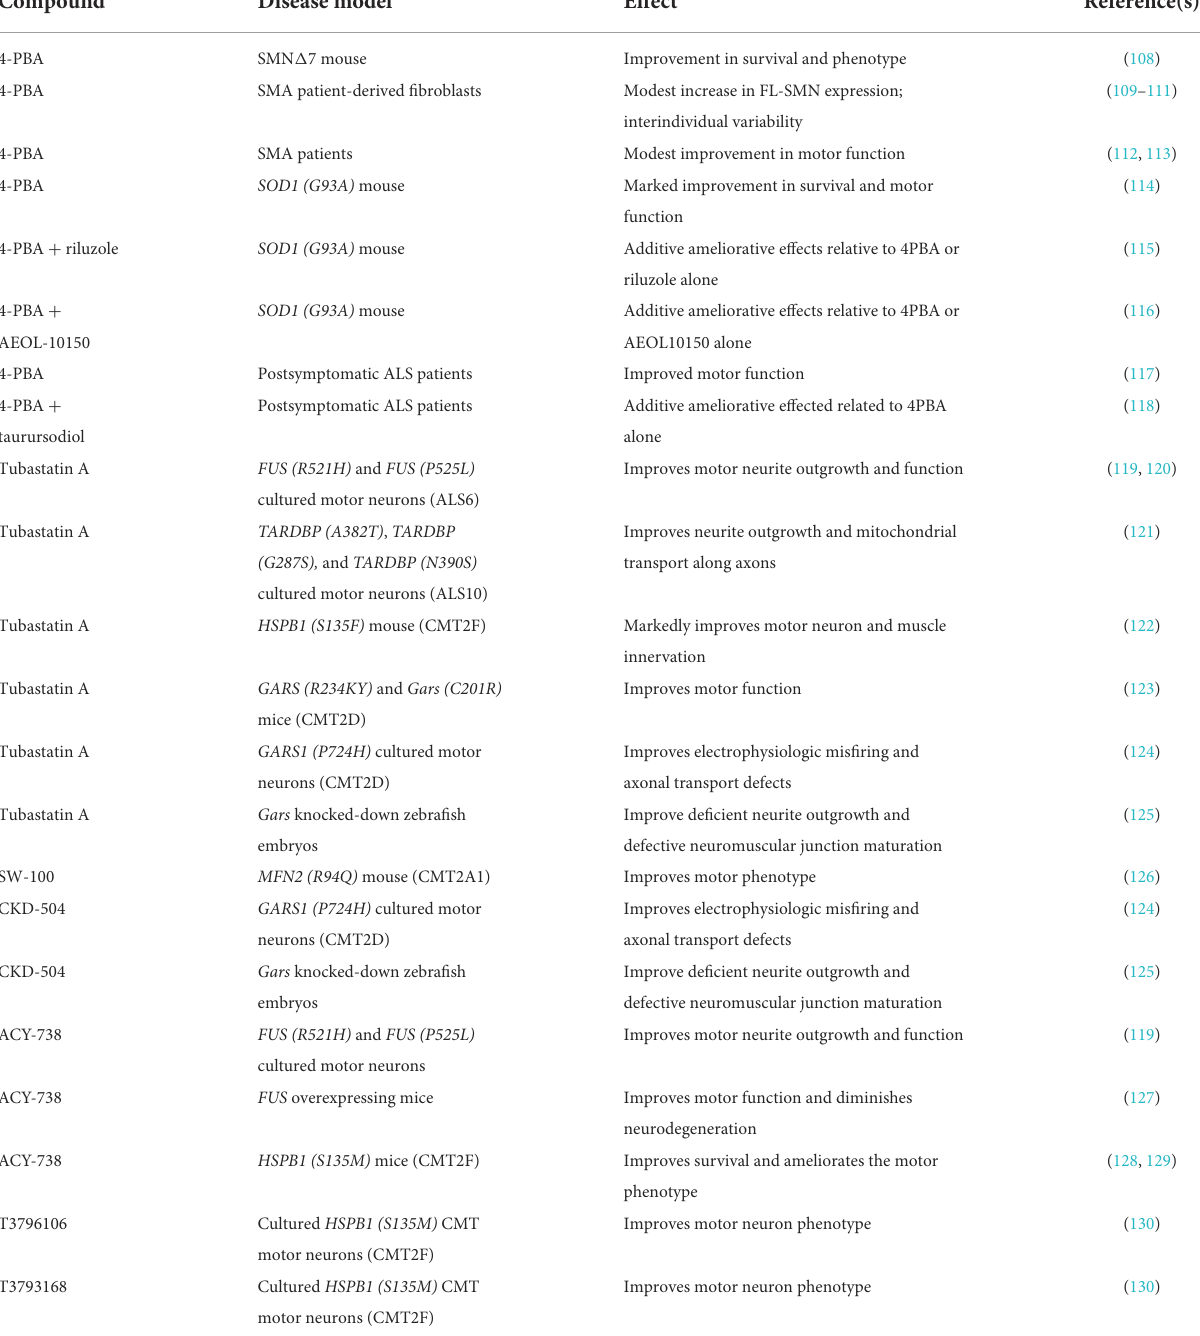
TABLE 1 Summary of 4-PBA and HDAC6 inhibitors demonstrating therapeutic benefit in model systems for early-onset motor neuron diseases.